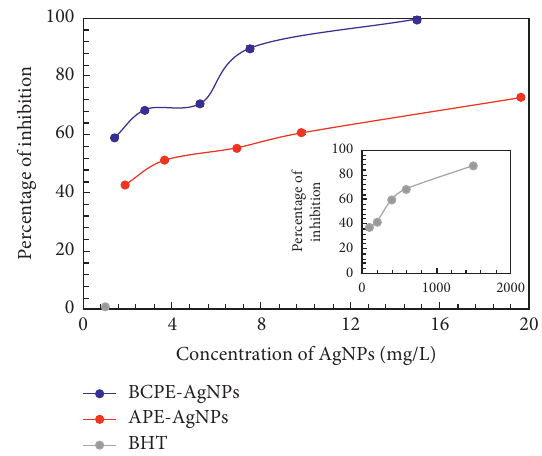
Figure 10: DPPH radical activity of the BCPE-AgNPs and APE-